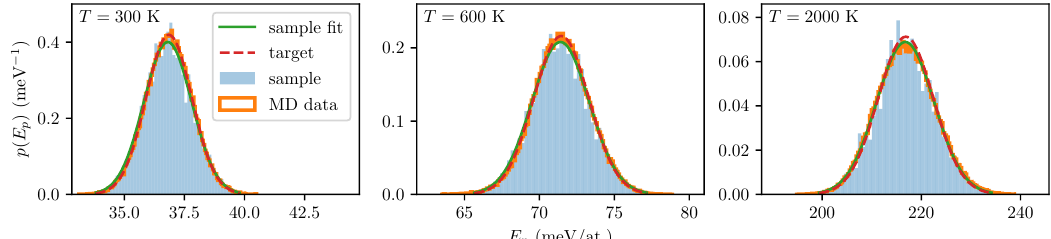
Figure 4: Probability distribution of potential energy per atom generated with HECSS scheme (blue shape) versus distribution extracted from the MD trajectory (orange contour). The dashed line indicates normal distribution fitted to MD sample. The data corresponds to the temperatures T = 300, 600 and 2000 K (as labeled in sub-